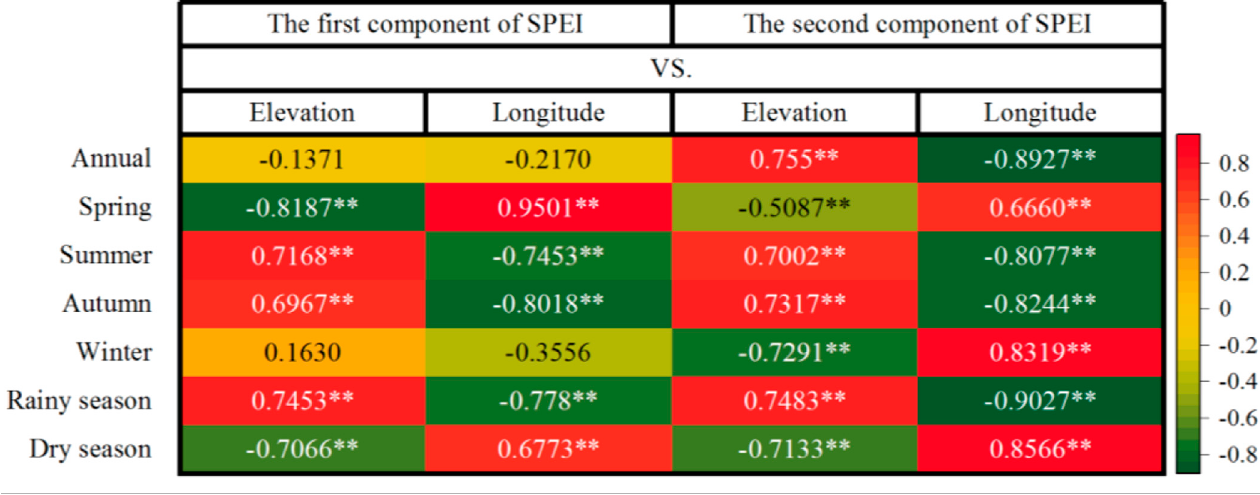
Frontiers in Environmental Science |